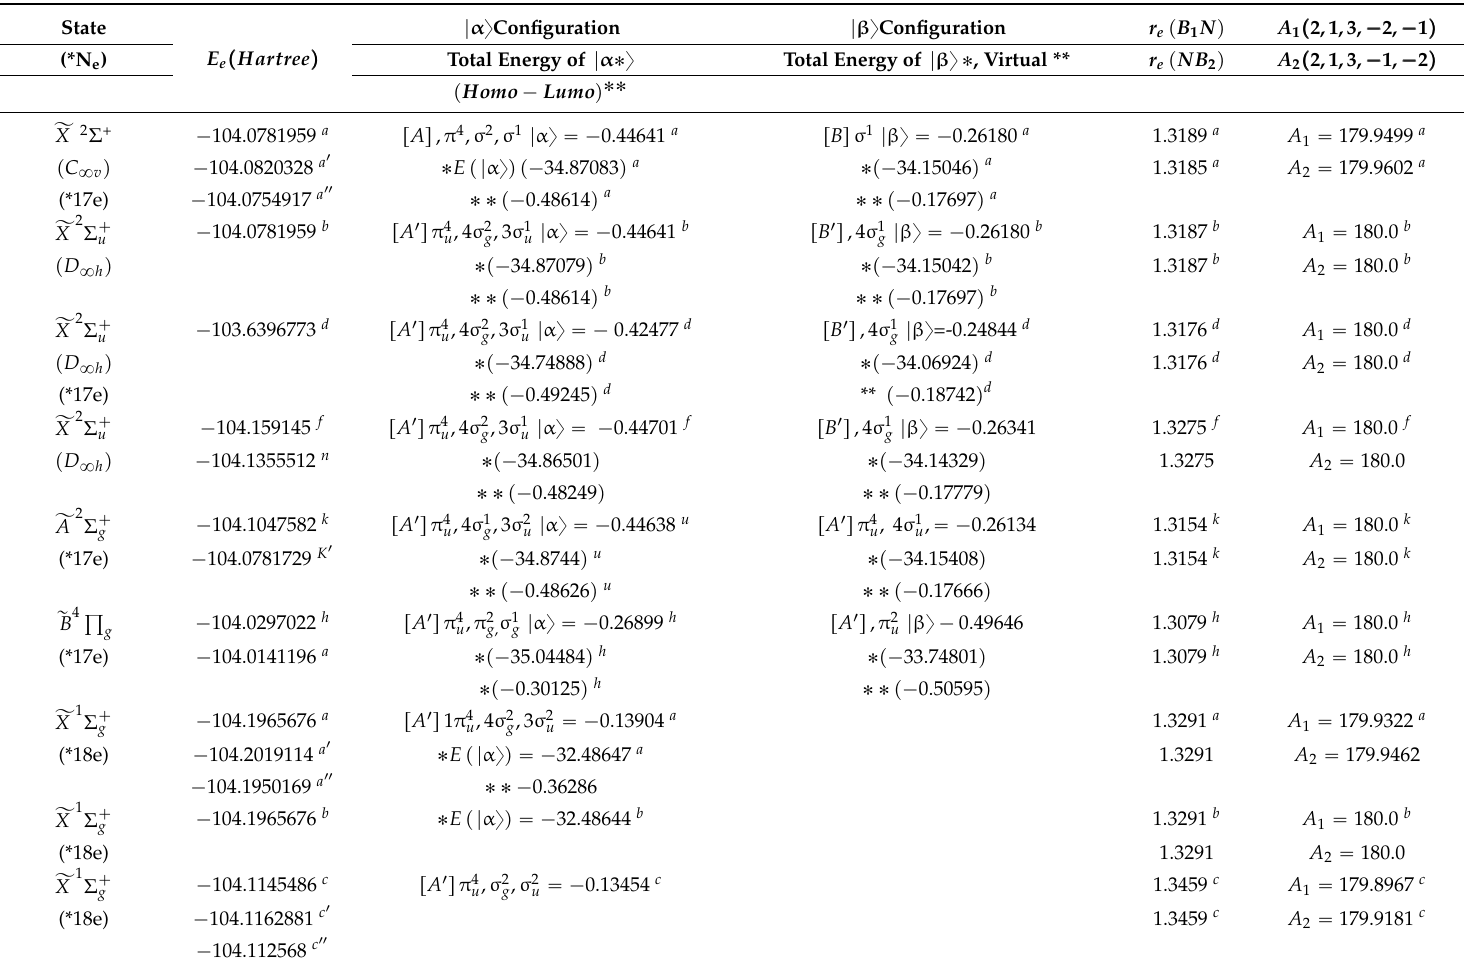
Table 1. Geometric and electronic structures of B 2 N p´ ,0, `q in ground and exited